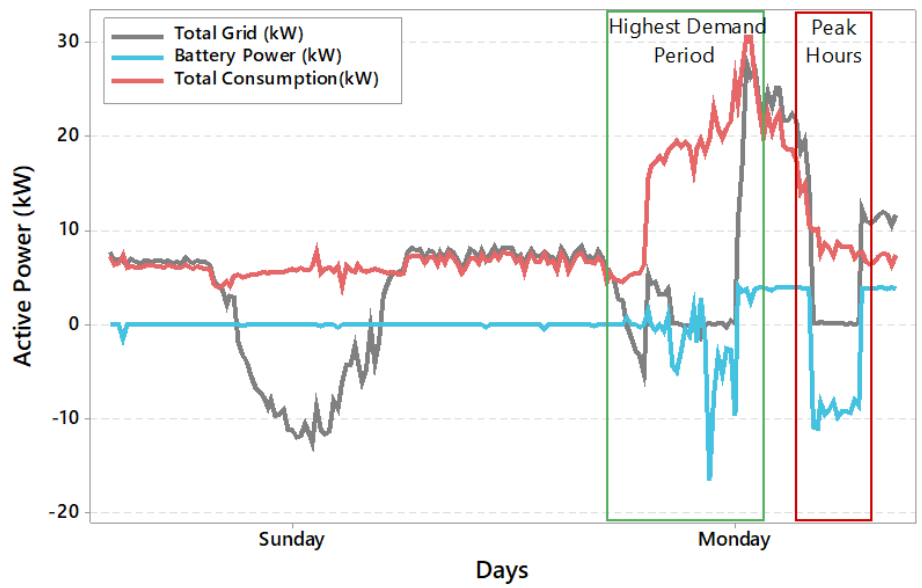
Figure 9. Total power balance for hybrid mini-grid operation.